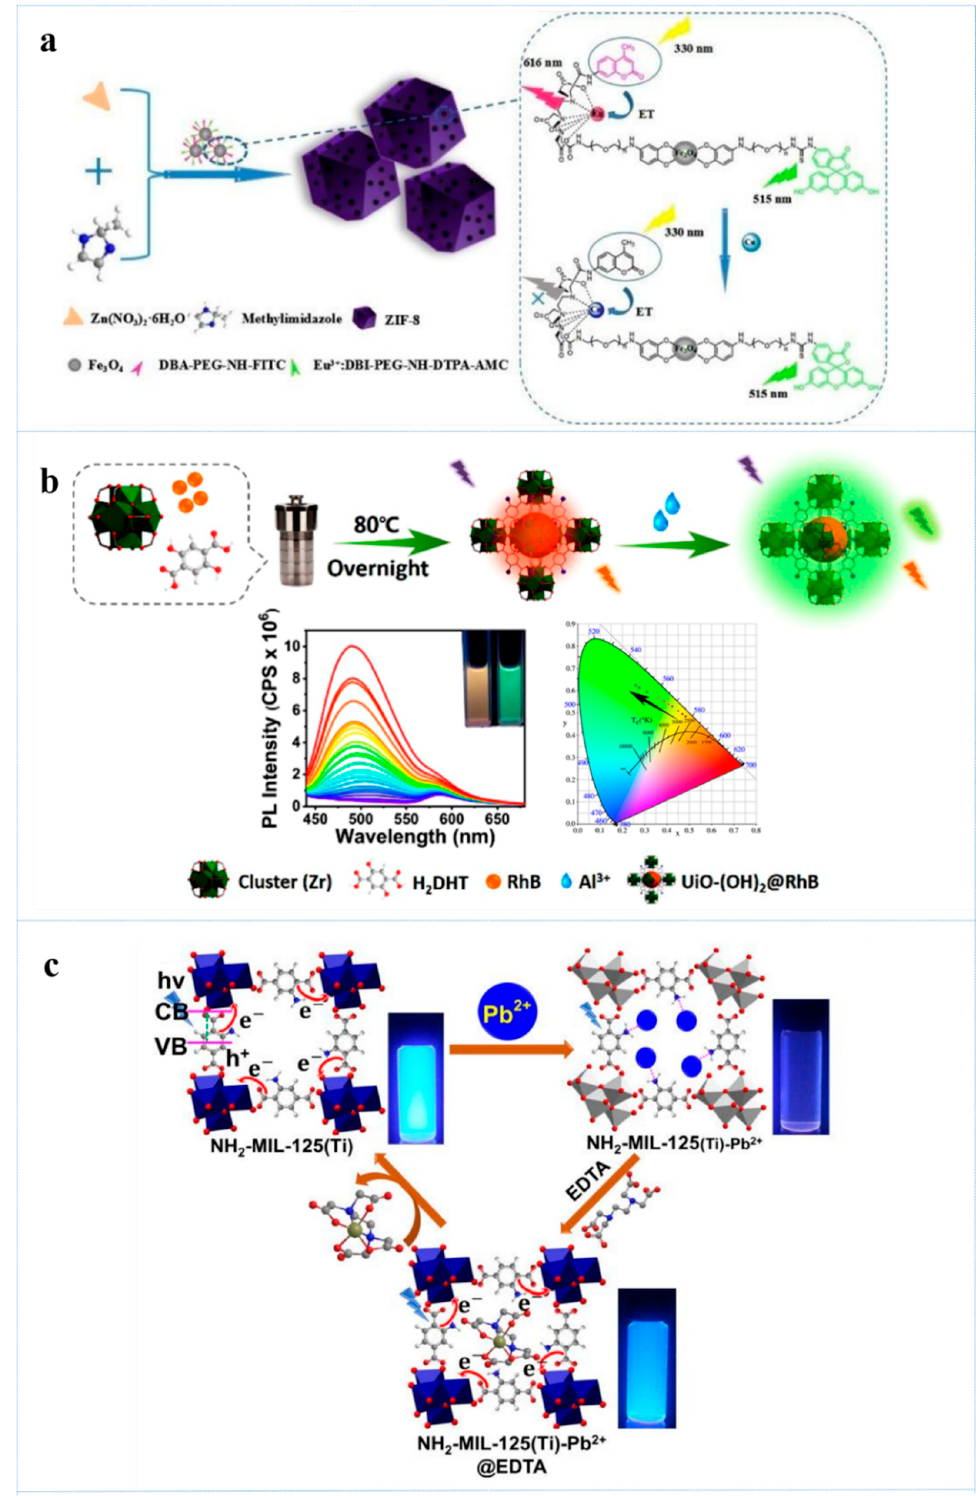
Figure 5. ( a ) Schematic illustration of the process for encapsulating the lanthanide complex modified Fe 3 O 4 into ZIF-8 and concept for sensing Cu 2+ , reprinted with modifications from Wang et al. [99]; ( b ) schematic illustration of the fabrication of UiO-(OH) 2 @RhB and the sensing process to Al 3+ , reprinted with modifications from Zheng et al. [110]; ( c ) schematic of the fluorescence quenching and recovery mechanisms of NH 2 -MIL-125, reprinted with modifications from Venkateswarlu et al. [113].